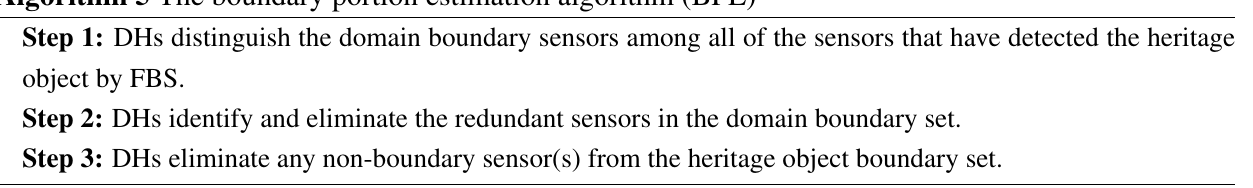
Algorithm 5 The boundary portion estimation algorithm